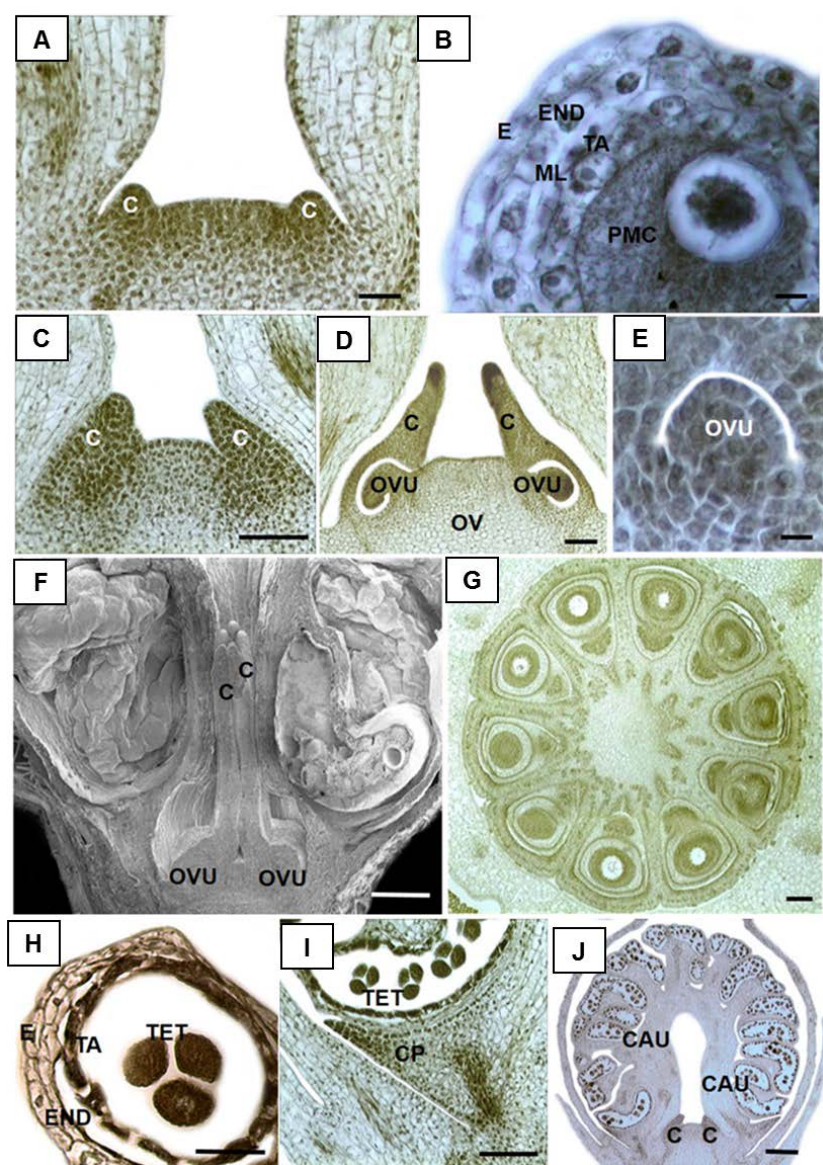
Fig. 5. Stage 7: Carpel primordia initiation (A, B) and Stage 8: Ovary and ovule formation (C-J). A. Carpel primordia differentiation. B. PMC with generous cytoplasm and huge nucleus. C. Growing upwardly of carpel primordium. D. Ovary and ovule formation. E. Ovule initiation. F. Growing and approaching to each other of carpel primordia, as seen in SEM (Five of ten). G. An ovary with 10 loculi. H. Anther wall layers and microspore tetrad. I. Corolla primordia elongation. J. CAU units elongation. C: Carpel primordia, CAU: Corolla/androecium units, CP: Corolla primordium, E: Epidermis, END: Endothecium, ML: Middle layer, OV: Ovary, OVU: Ovule, PMC: Pollen mother cell, TA: Tapetum, TA: Tapetum, TET: Tetrad. Bar: 1µm (B, E), 5 µm (H, I), 10 µm (A, C, D, G), 20 µm (J), 200 µm